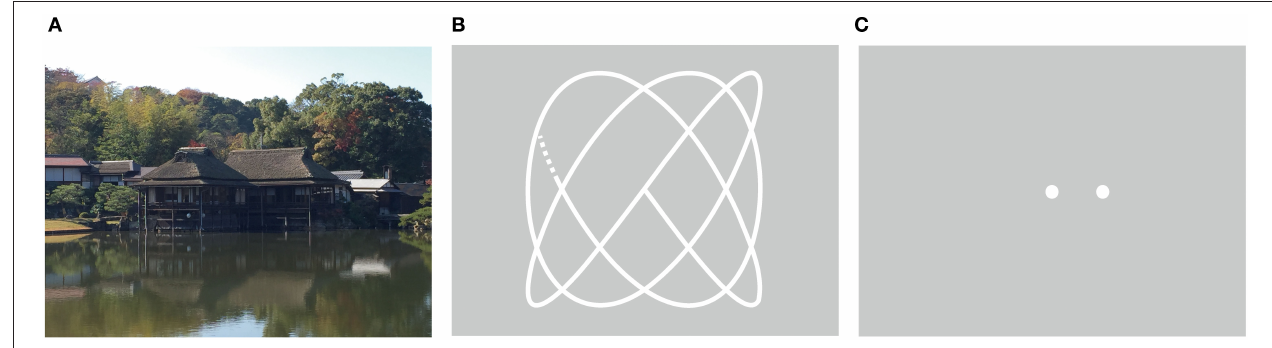
FIGURE 1 | Eye movement paradigms. (A) Free-viewing test*. (B) Lissajous trajectories of the smooth pursuit eye movement test. (C) Fixation stability test. The fixed target (center) and a distracter stimulus (right). *This image example is a photo taken by the author which is not the actual one used for the test.